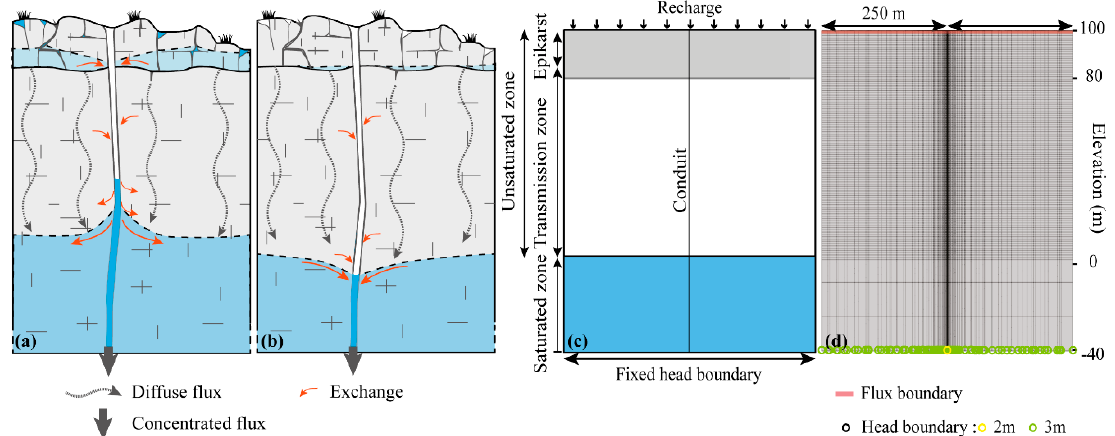
Figure 1. Schematic representation of water flux and exchanges through karst as a function of the hydrological period and corresponding numerical model. ( a ) High flow conceptual model: the conduits drain the upper continuum and supply the lower continuum; ( b ) Low flow conceptual model: the conduits drain the surrounding continuum; ( c ) subsystems of the numerical model; ( d ) associated mesh with boundary conditions.